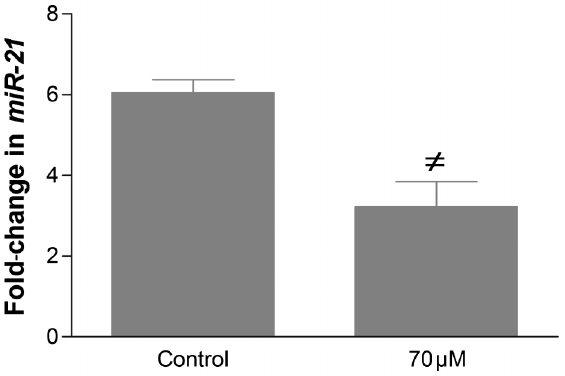
Figure 6. miR-21 gene expression in U87 cells. The y-axis indicates the fold-change in miR-21 expression. Data are reported as means ± SD for 3 measurements. The expression of miR-21 was compared between cells that had been treated with 70 m M kaurenoic acid (KA) for 48 h and untreated cells. ? P , 0.01 for 70 m M KA treatment vs control cells (Bonferroni multiple comparison